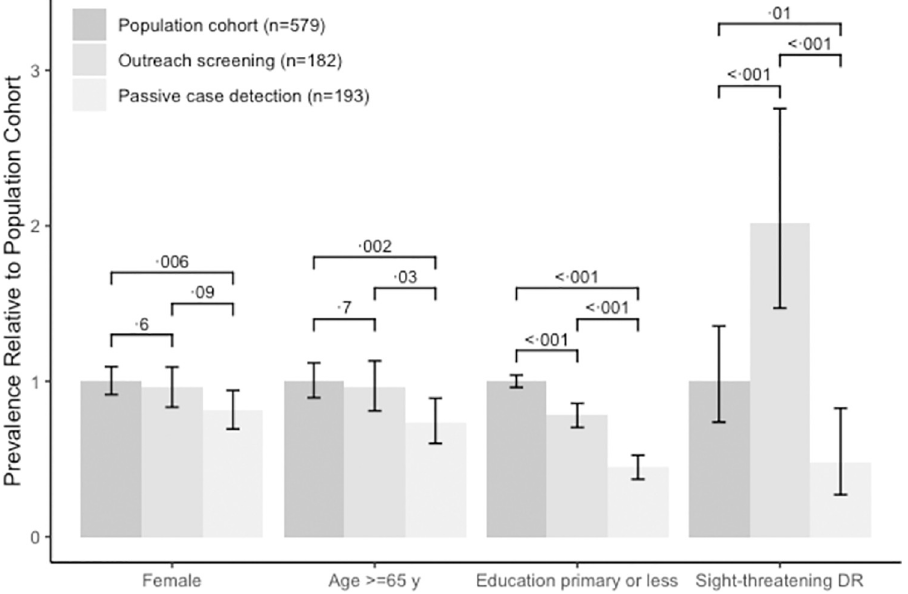
Fig 1. Comparison of indicators of socioeconomic disadvantage and sight threatening DR between cohorts of patients with DM accessed through passive case detection at secondary level hospitals (n = 193) and primary-level outreach screening (n = 182) with reference to a population-based cohort (n = 579).